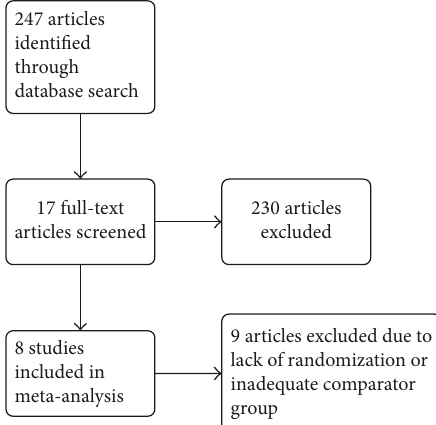
Figure 1: Flow diagram of study